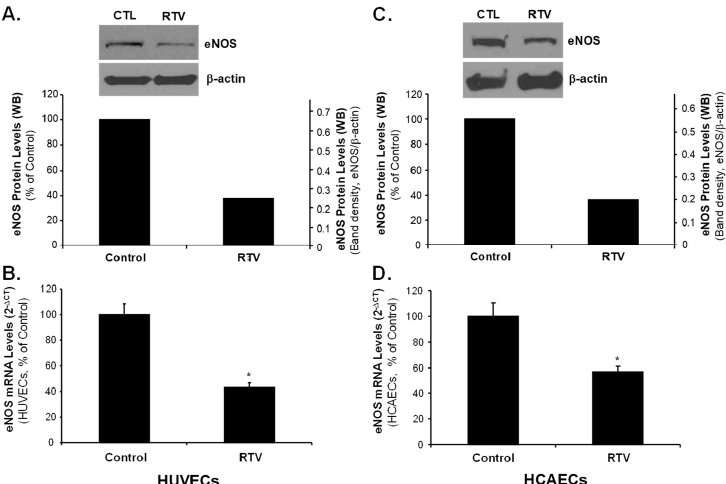
Figure 5. Effect of ritonavir on eNOS expression in human endothelial cells. HUVECs (human umbilical vein endothelial cells) and HCAECs (human coronary artery endothelial cells) were treated with ritonavir (RTV, 15 µ M) or DMSO (negative control) for 24 h. The expression of eNOS was determined by Western blot and real-time PCR analysis. ( A ) Protein levels of eNOS (Western blot) in HUVECs. The density of Western blot bands was analyzed by using NIH ImageJ software. Protein level of eNOS in the control cells was standardized as 100%, while protein level of eNOS in RTV-treated cells was compared with that of the control; ( B ) mRNA levels of eNOS (real time PCR) in HUVECs. eNOS mRNA levels were standardized with untreated control cells as 100%; ( C ) Protein levels of eNOS (Western blot) in HCAECs; ( D ) mRNA levels of eNOS (real time PCR) in HCAECs. Student’s t -test was used to compare the control with the treated groups. n = 3. * p <